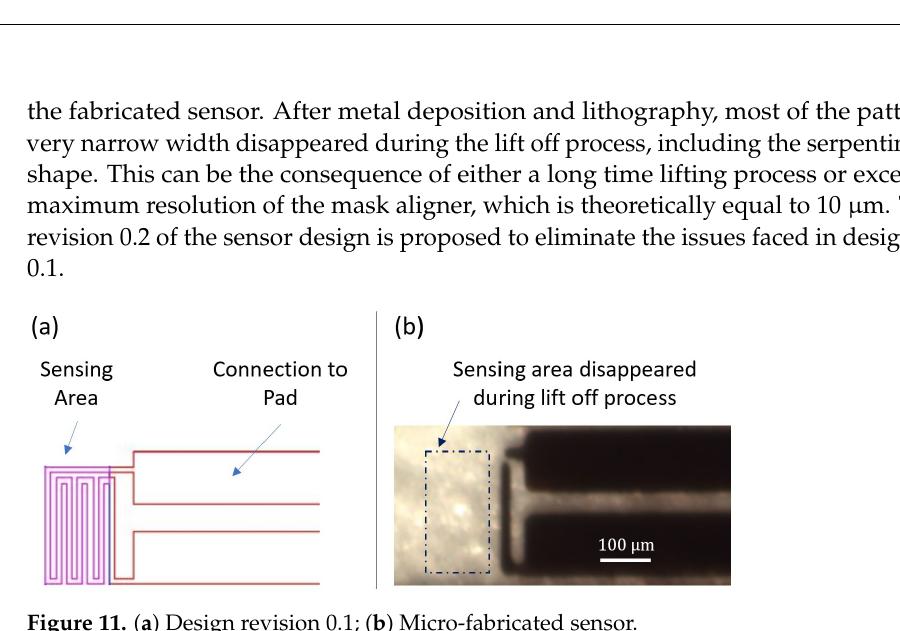
Figure 11. ( a ) Design revision 0.1; ( b ) Micro-fabricated sensor.